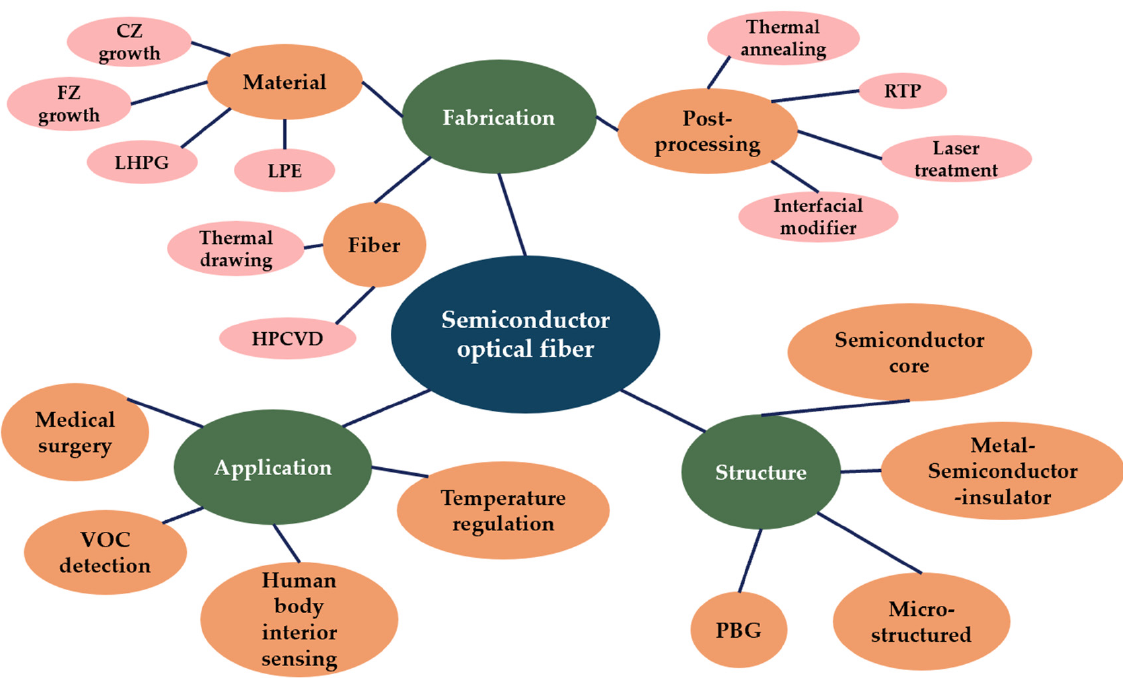
Figure 1. A summary of this review about biomedical semiconductor optical fibers.